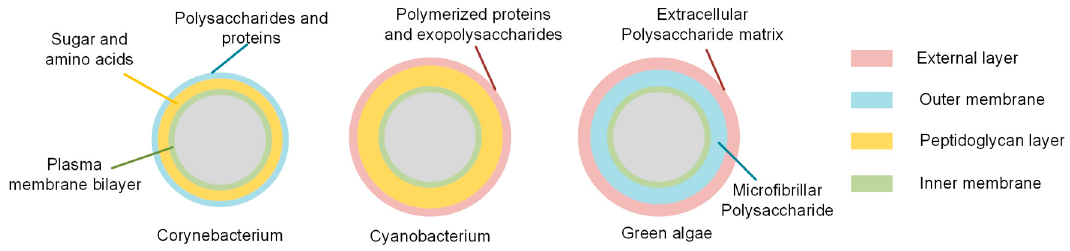
Figure 1. A representative illustration of the cell envelops of Corynebacterium, cyanobacterium species, and green algae.